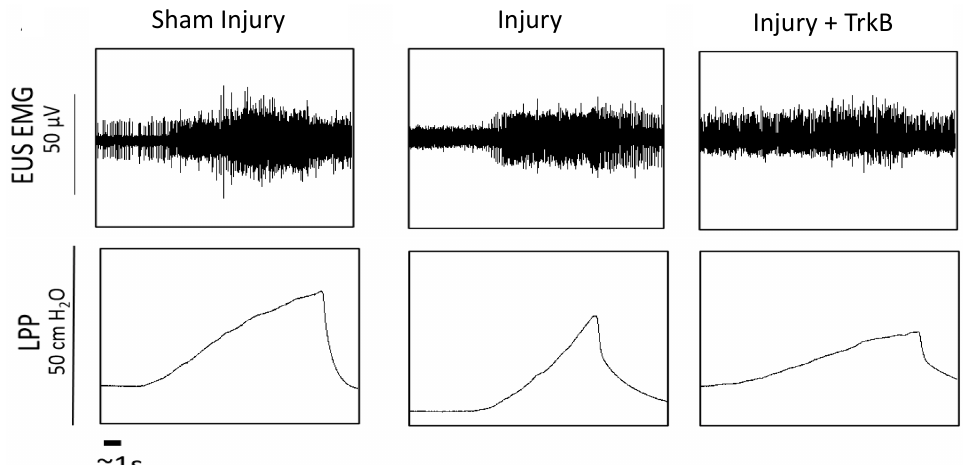
Figure 1. Examples of functional outcomes. Examples of external urethral sphincter electromyogra- phy (EUS EMG; top ) and corresponding bladder pressure ( bottom ) from each of the three groups 6 weeks after injury: sham dual injury treated with saline (Sham Injury); pudendal nerve crush (PNC) and vaginal distension (VD) injury treated with saline (Injury); and PNC + VD injury treated with tyrosine kinase B (TrkB) fusion chimera (Injury + TrkB). Scale bar represents 1 s. Each animal was tested individually, and LPP and EUS EMG were recorded simultaneously. Representative examples were chosen by being close to the respective means for both outcomes.